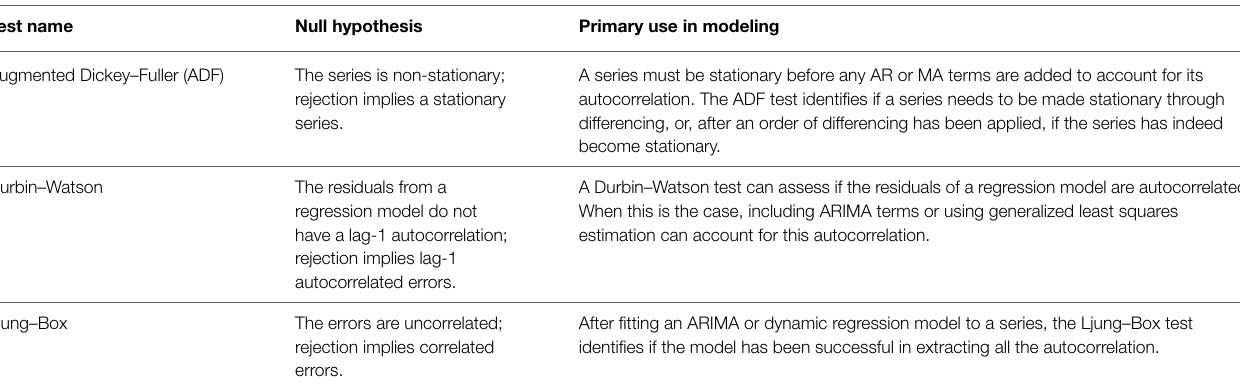
TABLE 1 | Common tests in time series